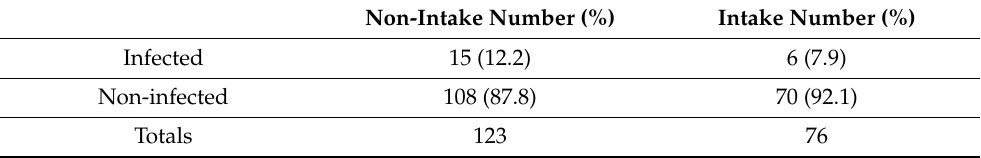
Table 12. Preliminary test of the preventive effect of forsythia leaf tea against influenza A virus infection.